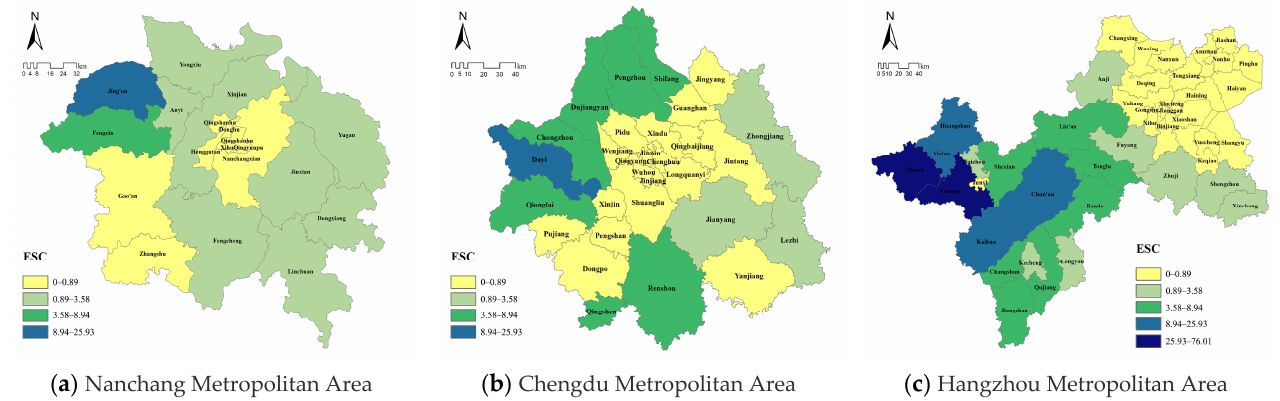
Figure 6. Ecological support coefficients of three metropolitan areas.